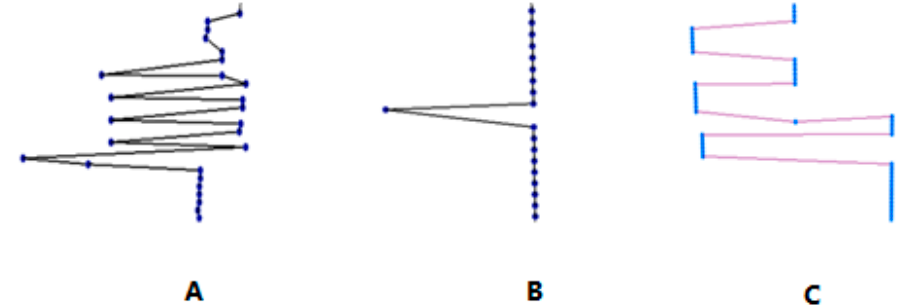
Figure 8. Types of drift phenomenon in the stay trajectories.